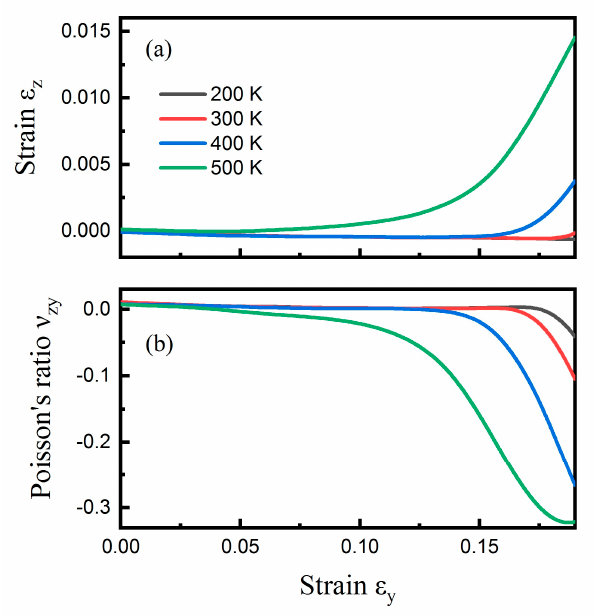
Figure 4. Temperature effect. The influence of temperature on the positive–negative Poisson’s ratio transition for CHC subjected to uniaxial tensile tests in the armchair (y) direction. ( a ) Engineering strain ε z versus ε y at temperatures ranging from 200 to 500 K. ( b ) The corresponding ν zy for CHC at different temperatures.